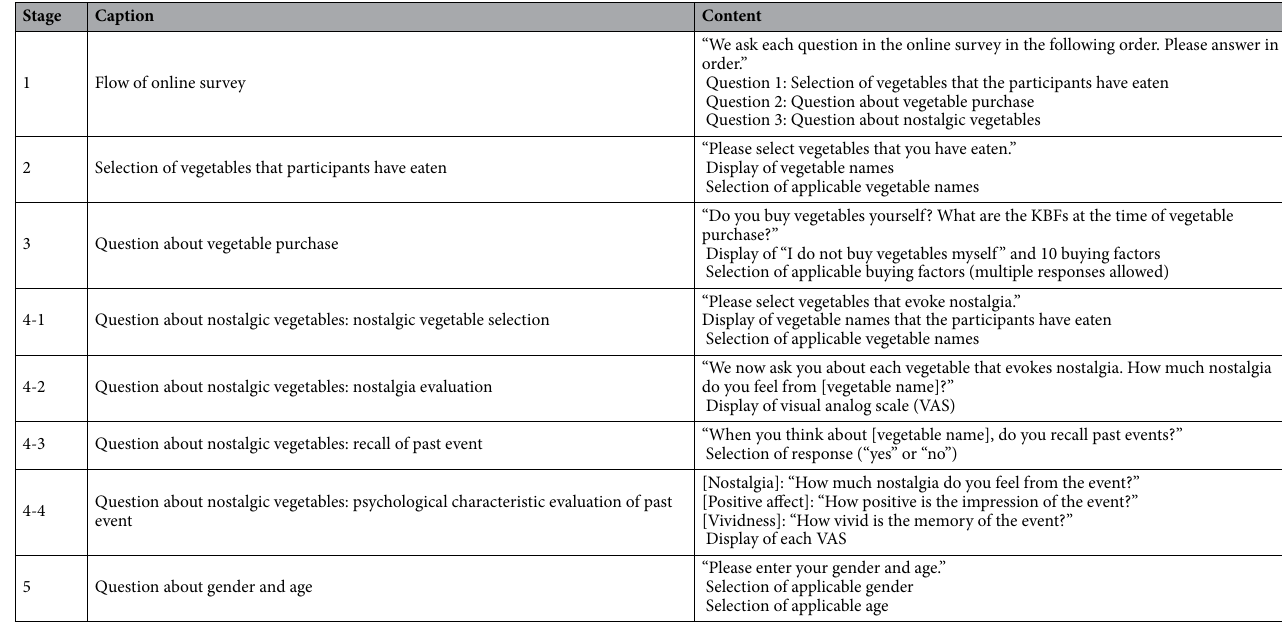
Table 1. Outline of online survey on nostalgic